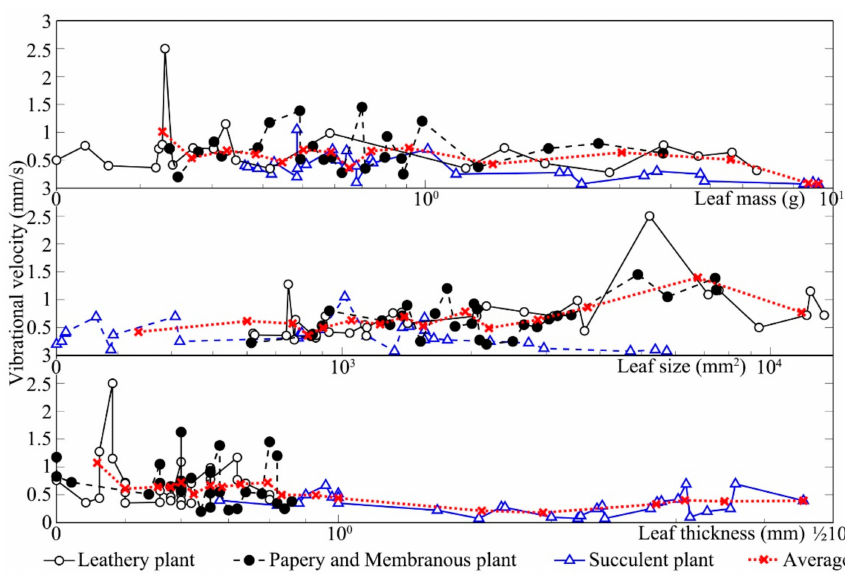
Figure 8. Vibrational velocities of three di ff erent kinds of